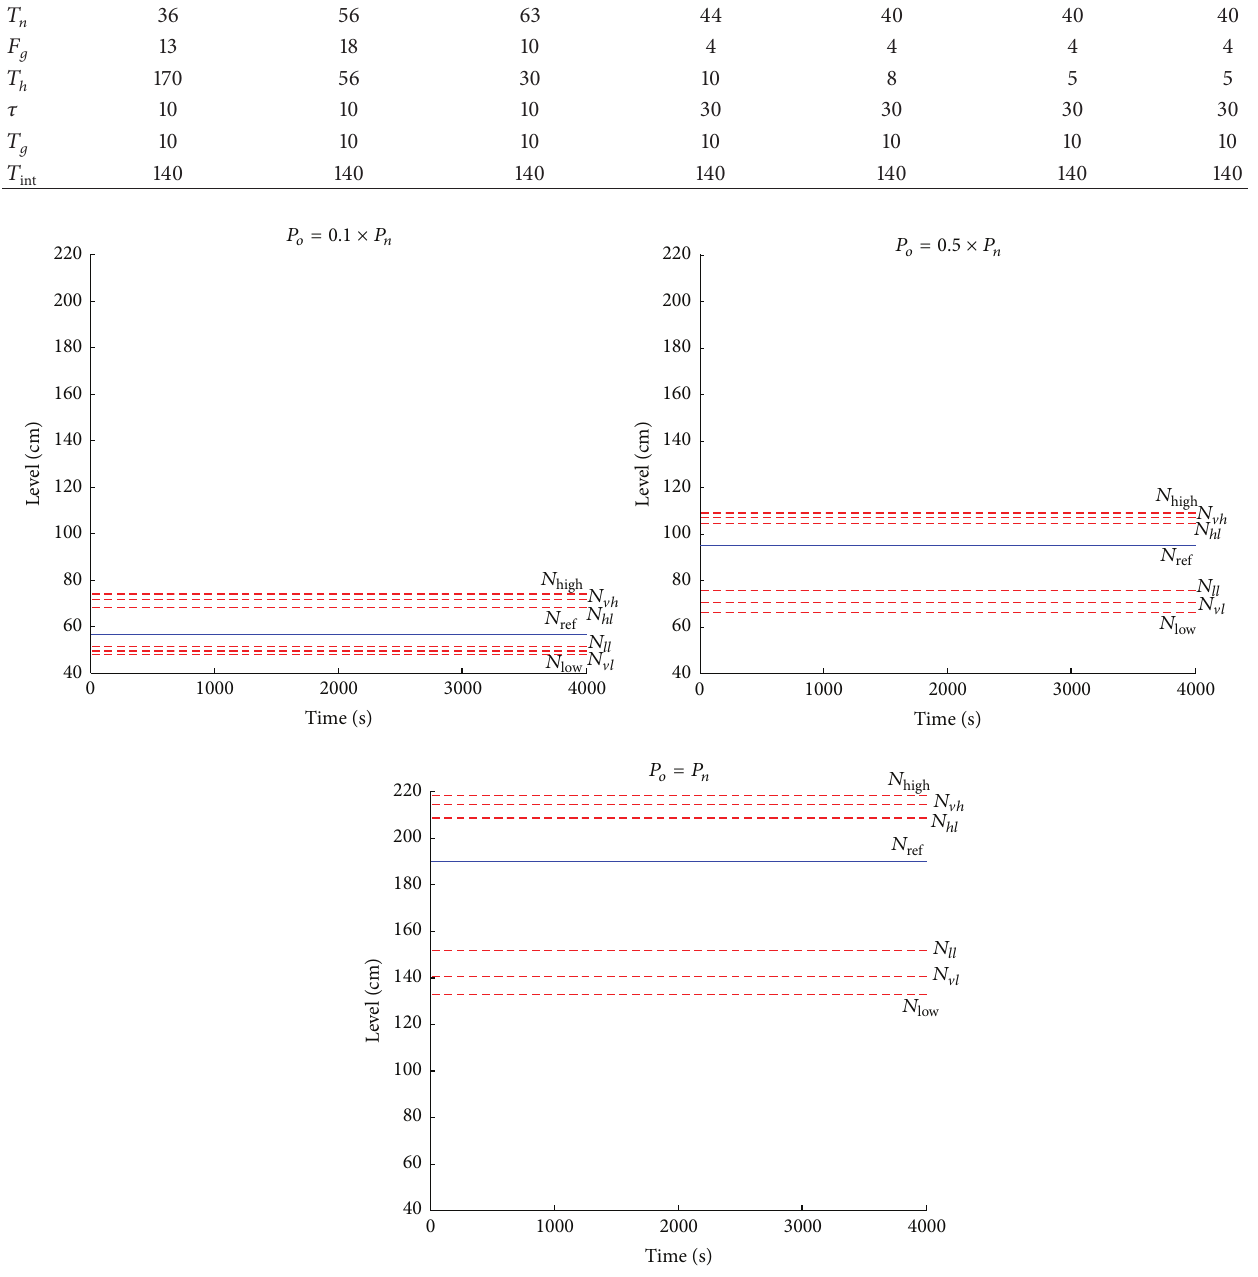
Figure 2: Set point for 𝑁